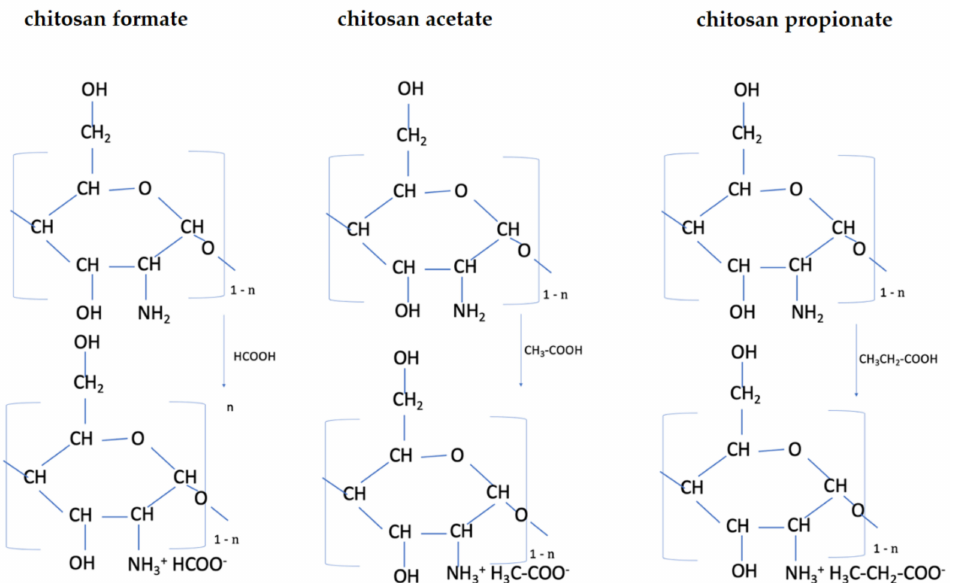
Figure 1. Example of the formation of chitosan salts in the presence of different carboxylic acids, where n is the degree of deacetylation (n =